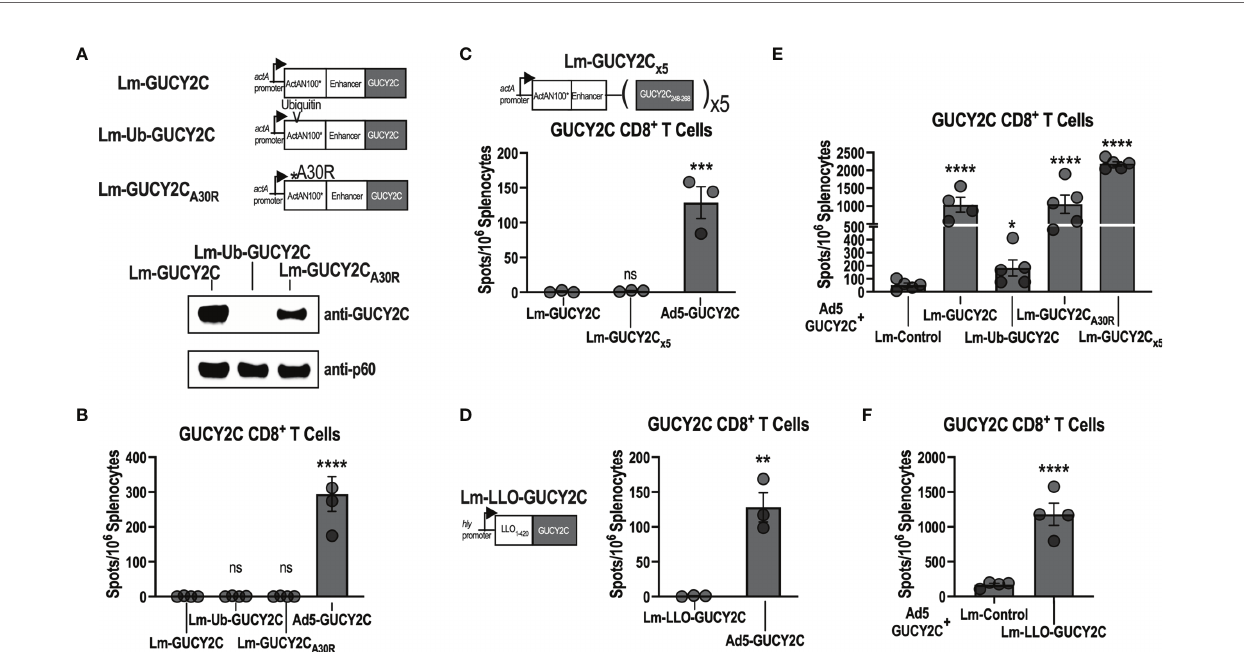
FIGURE 2 | Lm-GUCY2C vaccines designed to enhance antigen processing do not improve GUCY2C 254-262 immunogenicity. (A) Lm-GUCY2C used in Figure 1 secretes a fusion protein consisting of ActAN100* combined with an enhancer sequence and GUCY2C. Lm-GUCY2C A30R contains a point mutation at the N- terminal residue following the signal sequence of actA, and Lm-Ub-GUCY2C contains ubiquitin protein following the signal sequence within ActAN100* to enhance degradation, con fi rmed by western blot analysis. (B) BALB/c mice (n=3-4/group) were immunized i.p. with 10 7 CFU of Lm vaccines or 10 10 vp of Ad5-GUCY2C vaccine and euthanized 7 or 14 d later, respectively, to quantify GUCY2C-speci fi c CD8 + T-cell responses by IFN g ELISpot. (C) To enhance the quantity of GUCY2C 254-262 peptide and improve antigen processing, Lm-GUCY2C x5 secretes a fusion protein containing fi ve repeating copies of GUCY2C 248-268 separated by sequences predicted to facilitate proteasomal cleavage. BALB/c mice (n=3-4/group) were immunized i.p. with 10 7 CFU of Lm-GUCY2C x5 vaccine or 10 10 vp of Ad5-GUCY2C vaccine and euthanized 7 or 14 d later, respectively, to quantify GUCY2C-speci fi c CD8 + T-cell responses by IFN g ELISpot. (D) Lm-LLO-GUCY2C secretes a fusion protein comprised of a truncated LLO protein fused to GUCY2C under control of the hly promoter. BALB/c mice (n=3/group) were immunized i.p with 10 7 CFU of Lm-LLO-GUCY2C or i.m. with 10 10 vp of Ad5-GUCY2C and GUCY2C-speci fi c CD8 + T-cell responses were quanti fi ed by IFN g ELISpot 7 or 14 d later, respectively. (E, F) BALB/c mice (n=4-5/group) were immunized i.m. with 10 10 vp of Ad5-GUCY2C vaccine on day 0 followed by 10 7 CFU of